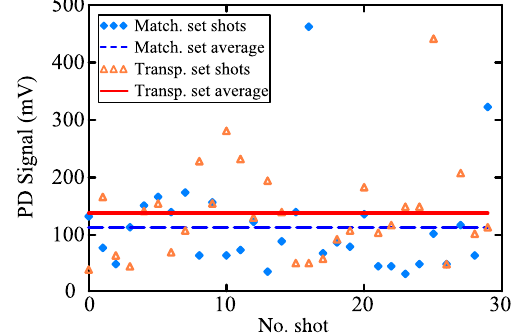
FIG. 4. Experimental sets of data corresponding to the different matching and transport configuration for the magnetic elements in the SPARC FEL (Table II). The signal detected by the photodiode (PD) is pointed together with the average value for the two sets of data. Only a relative difference can be appreciated in intensity since the PD is not calibrated; the beam parameters are reported in Table III.